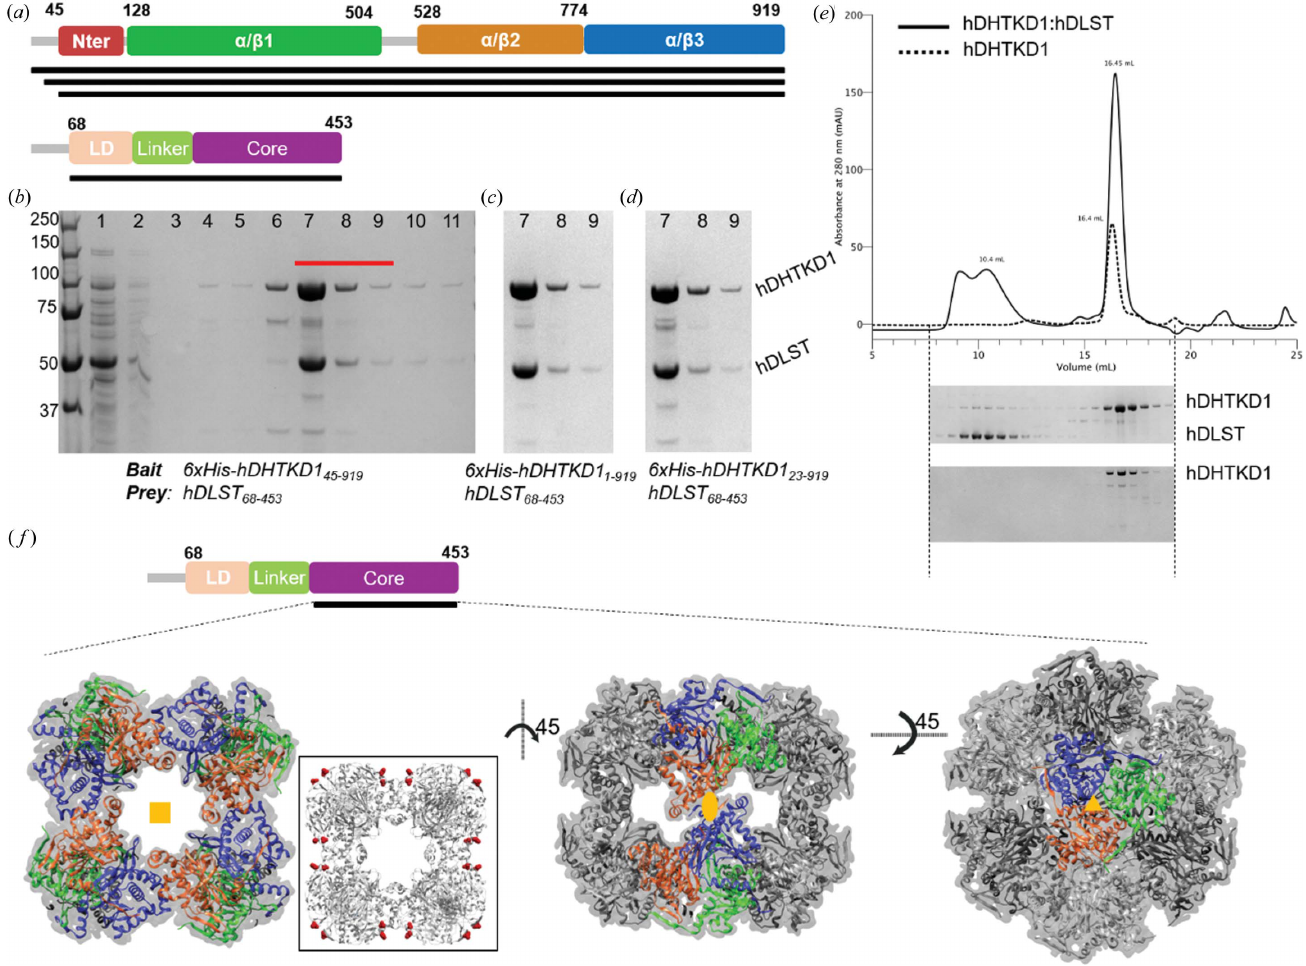
Figure 3 Interaction studies of hDHTKD1 and hDLST. ( a ) Constructs of hDHTKD1 and hDLST (black bars) used in the affinity pulldown experiments. ( b )–( d ) SDS–PAGE showing affinity pulldown of untagged hDLST 68–453 from ( b ) His 6 -tagged hDHTKD1 45–919 , ( c ) hDHTKD1 1–919 and ( d ) hDHTKD1 23–919 . The original uncropped SDS–PAGE gels are shown in Fig. S7. For panel ( b ), the lanes loaded are: 1, flow-through; 2–6, wash fractions of increasing imidazole concentration; and 7–11, elution fractions with 250 m M imidazole. SDS–PAGE gel fragments from panels ( c ) and ( d ) show only the first three elution fractions i.e. lanes 7, 8 and 9 [equivalent to the lanes marked in red in panel ( b )]. ( e ) Chromatogram and SDS–PAGE from SEC runs of hDHTKD1 45–919 protein alone (dashed line) and of hDHTKD1 45–919 co-expressed with hDLST 68–453 . Elution volumes for the complex peak and hDHTKD1-alone peak are shown. ( f ) An EM map of the hDLST 24-mer catalytic core overlaid with a humanized model of E. coli DLST (PDB code 1scz). The three views show how the trimer building block (monomers shown as blue, orange and green ribbons) is assembled into the 24-mer core via fourfold (left), twofold (middle) and threefold (right) symmetry axes, respectively. Inset of the left view shows how the first residue (aa 219, red spheres) from each of the 24 hDLST catalytic cores is distributed at the surface of the cube